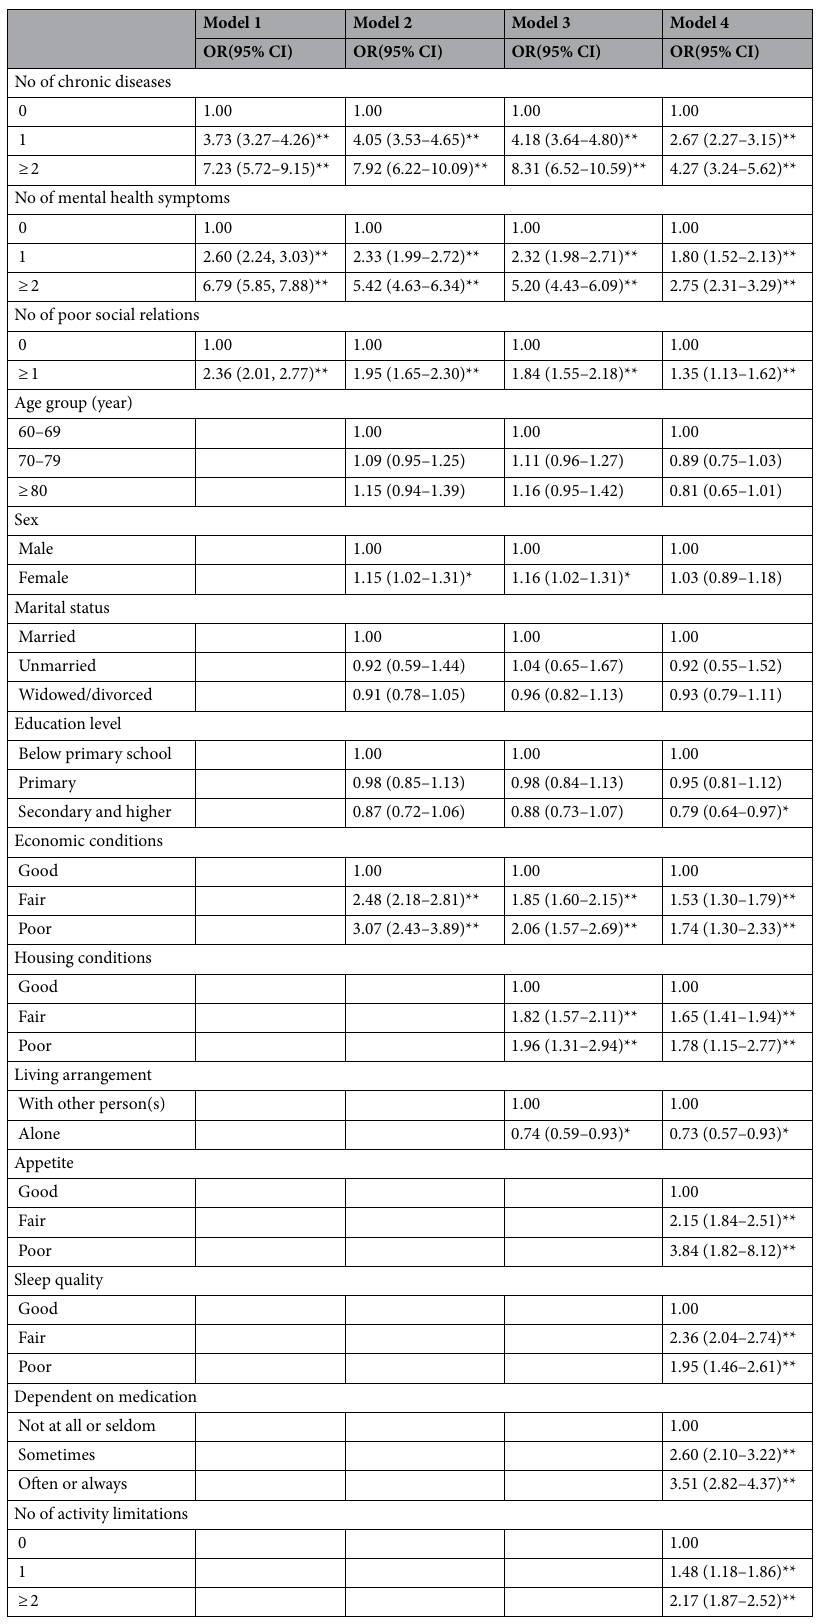
Table 4. Multivariate analysis of the relationship of chronic disease, mental health symptom and poor social relation with self-rated health. *The reference category is subjects without the specified condition, P < 0.05. **The reference category is subjects without the specified condition, P <